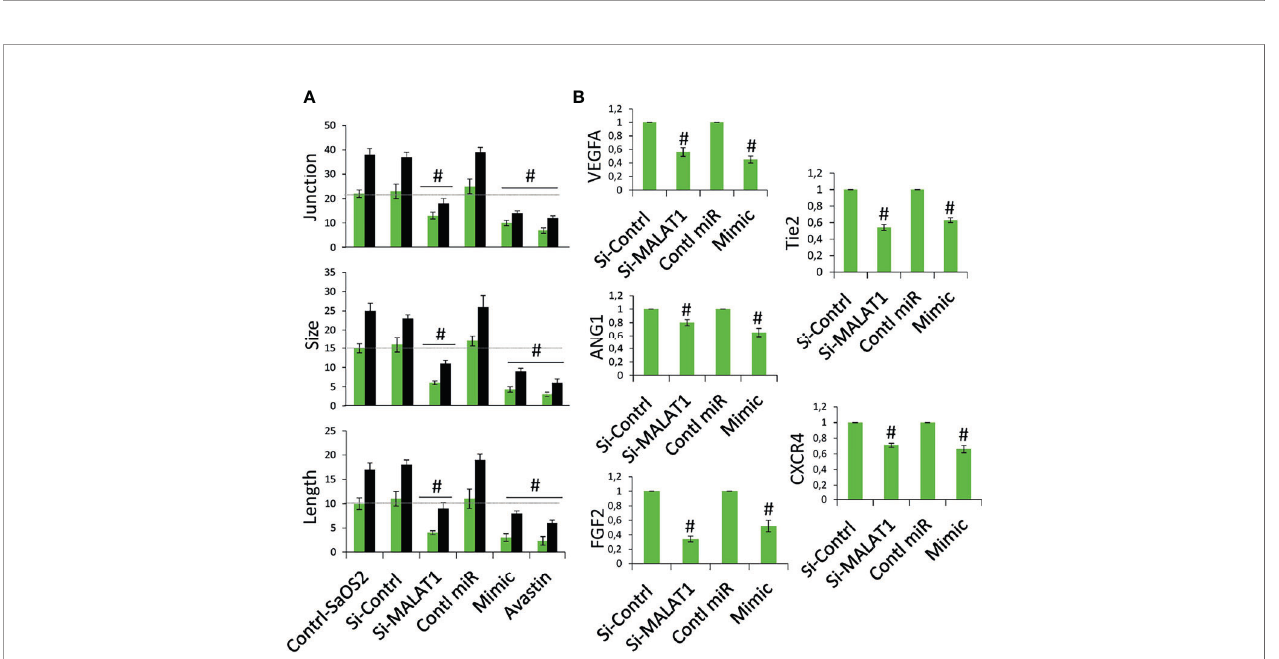
FIGURE 5 | Knockdown of MALAT1 and overexpression of miR-150-5p in OS suppress tumor angiogenesis by regulating VEGFA. (A) MG63 cells were transfected with si-MALAT/si-control/miR-150-5p mimic/control miR. After 24 h, the cells were exposed on CAM and the development of blood vessels was examined. In si-MALAT1 and miR-150-5p mimic transfection, angiogenic characteristics such as blood vessel size, junction, and length were reduced. Avastin, a VEGF inhibitor, was also employed as a positive control. Number sign indicates signi fi cant increase compared with control. For statistical analysis, only 6 h of treatment were considered. (B) Real-time RT-PCR was used to examine the angiogenic markers. A similar procedure was used, and the vascular bed from CAM was dissected and subjected to FGF2, VEGFA, CXCR4, Tie2, and ANG1 mRNA expression. Number sign indicates signi fi cant increase compared with